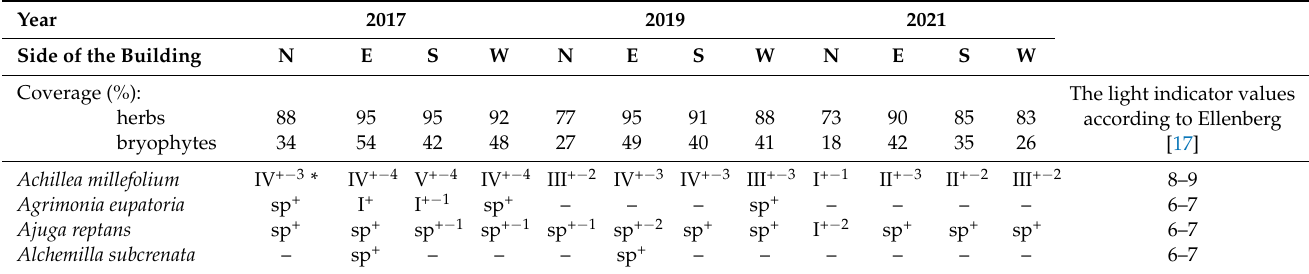
Table 1. The presence (sp and Roman numerals), abundance, and coverage (Arabic numerals and symbols in the degree) of plant species in the vertical column segments by year and by the exposition of the